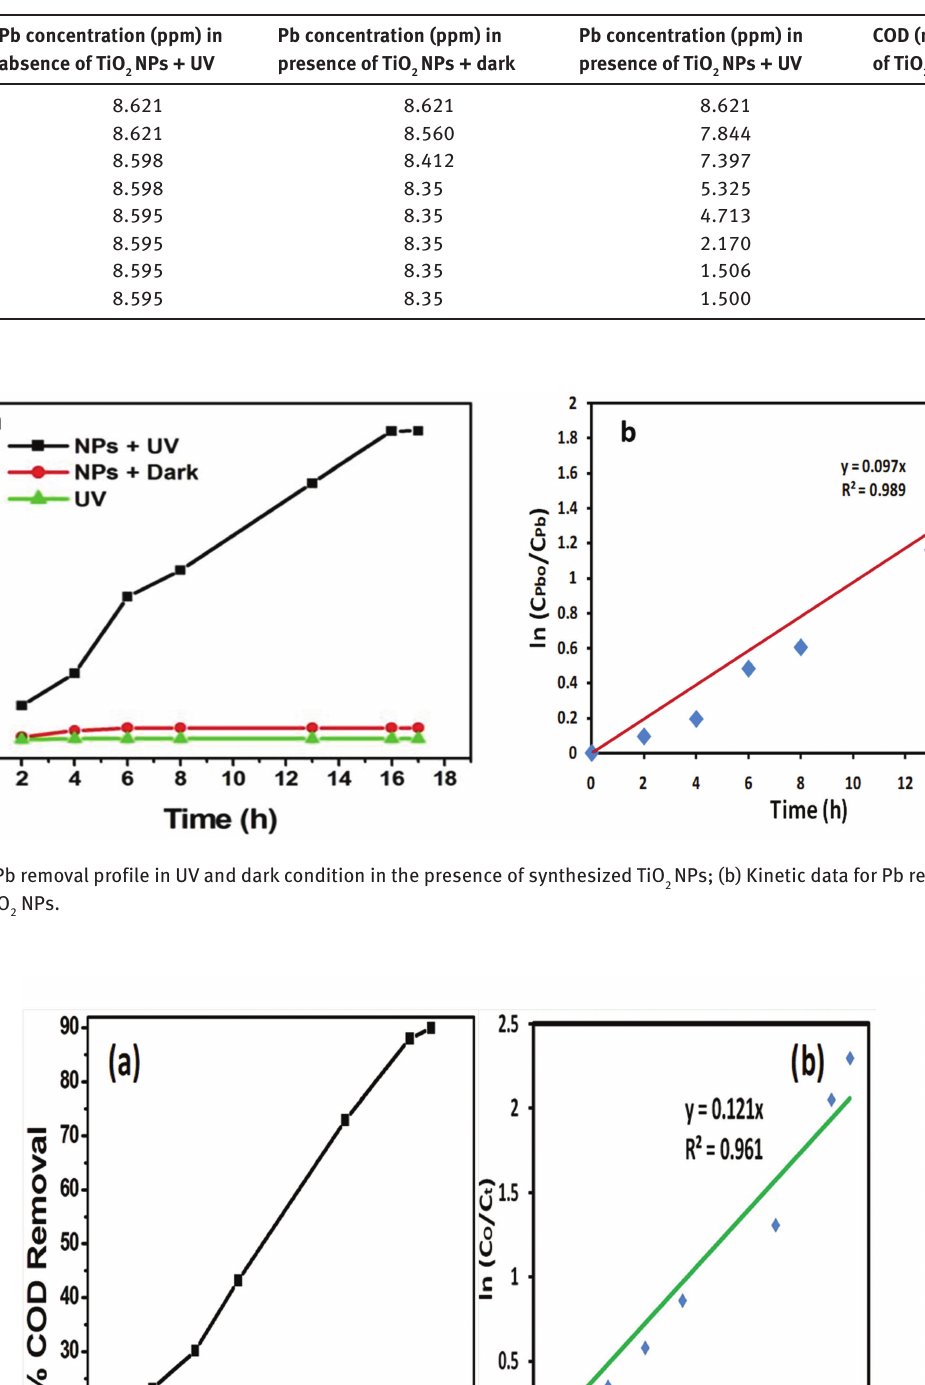
Figure 9: (a) COD removal profile in UV light; (b) Kinetic data for COD removal with the synthesized TiO